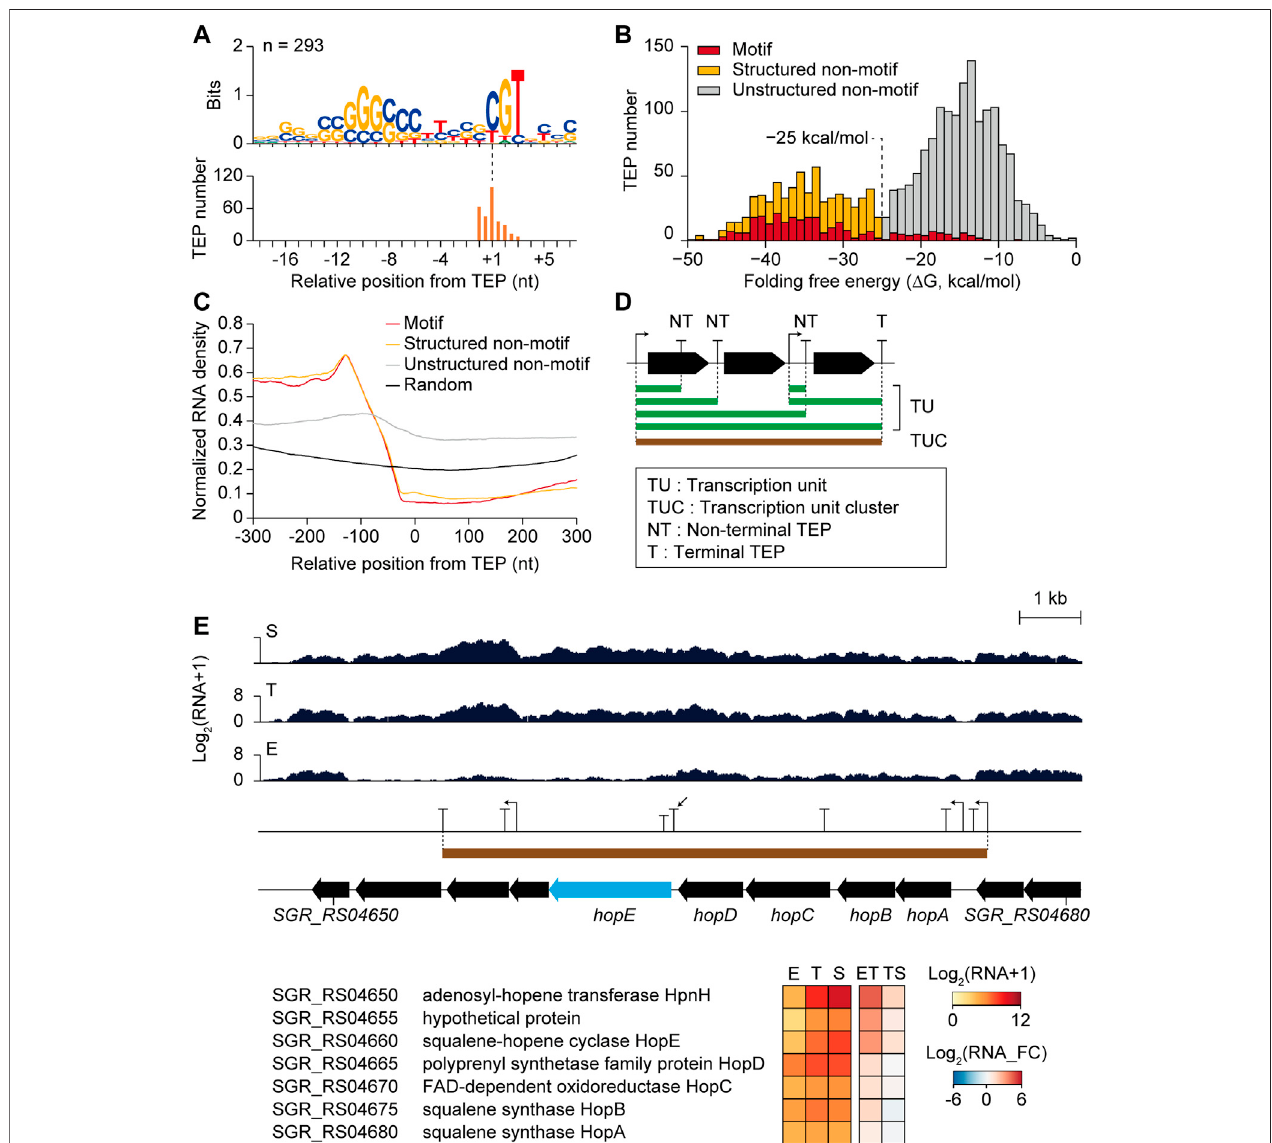
FIGURE 5 | Potential transcription termination and post-transcriptional regulatory elements of transcription 3 ′ -end positions (TEPs) affecting differential gene expressions. (A) ConservedTEPmotifssearchedbyMEMEwithzoopsparameter. (B) FoldingfreeenergydistributionoftotalTEPs(n=2,115),andthreesubcategories which areMotif TEPs having the conserved motif, Structured non-motif TEPs withhighly-structured RNA( < − 25 kcal/mol) withoutthe motif, and Unstructurednon-motif TEPs with less-structured RNA ( > − 25 kcal/mol) without the motif. (C) Normalized RNA density of three TEP subcategories and random intergenic positions. (D) Schematic representation of transcription unit (TU), transcription unit cluster (TUC), non-terminal TEP (NT), and terminal TEP (T). (E) An RNA-seq pro fi le example of the non-terminal TEP (indicated by arrow) having differentially expressed downstream gene ( hopE gene with sky blue color). Gene functions, expression levels, and fold changes of the genes within the TUC were